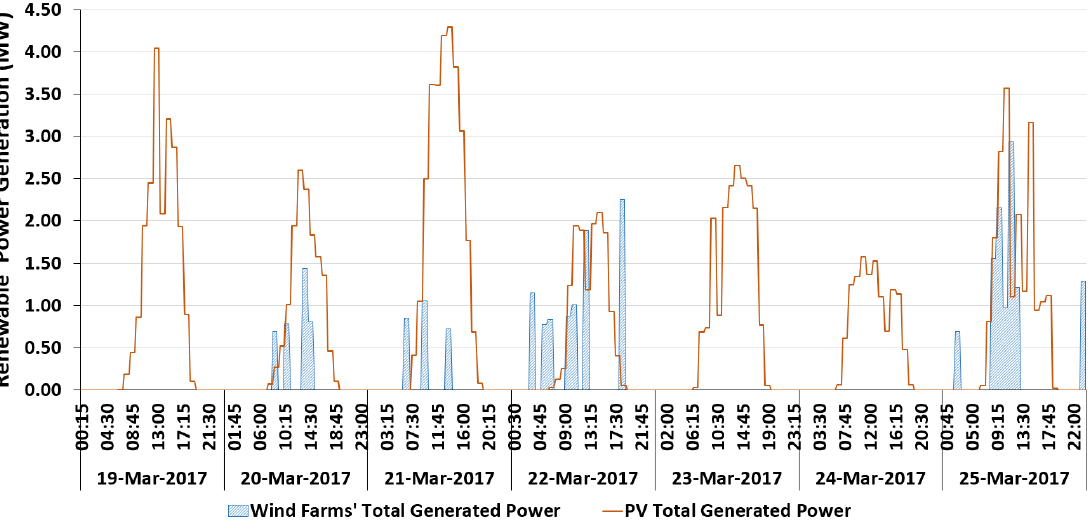
Figure 7. Renewable power